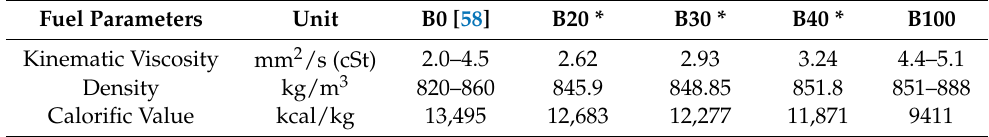
Table 2. Properties of diesel and biodiesel fuel blends used in this experiment.